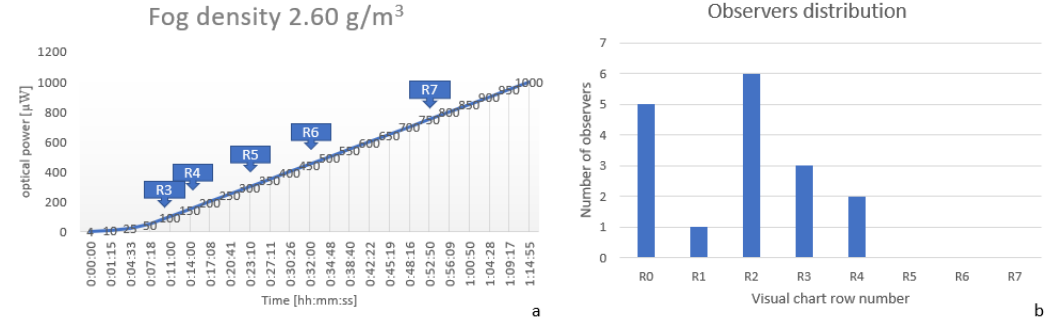
Figure 11. ( a ) Optical power and OCR measurements at a fog density of 2.60g/m 3 ( b ) Observers visual acuity distribution at a fog density of 2.60g/m 3